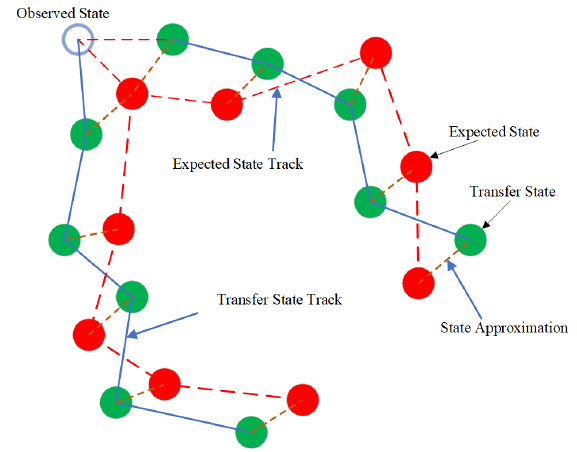
Figure 3. State Transition Association